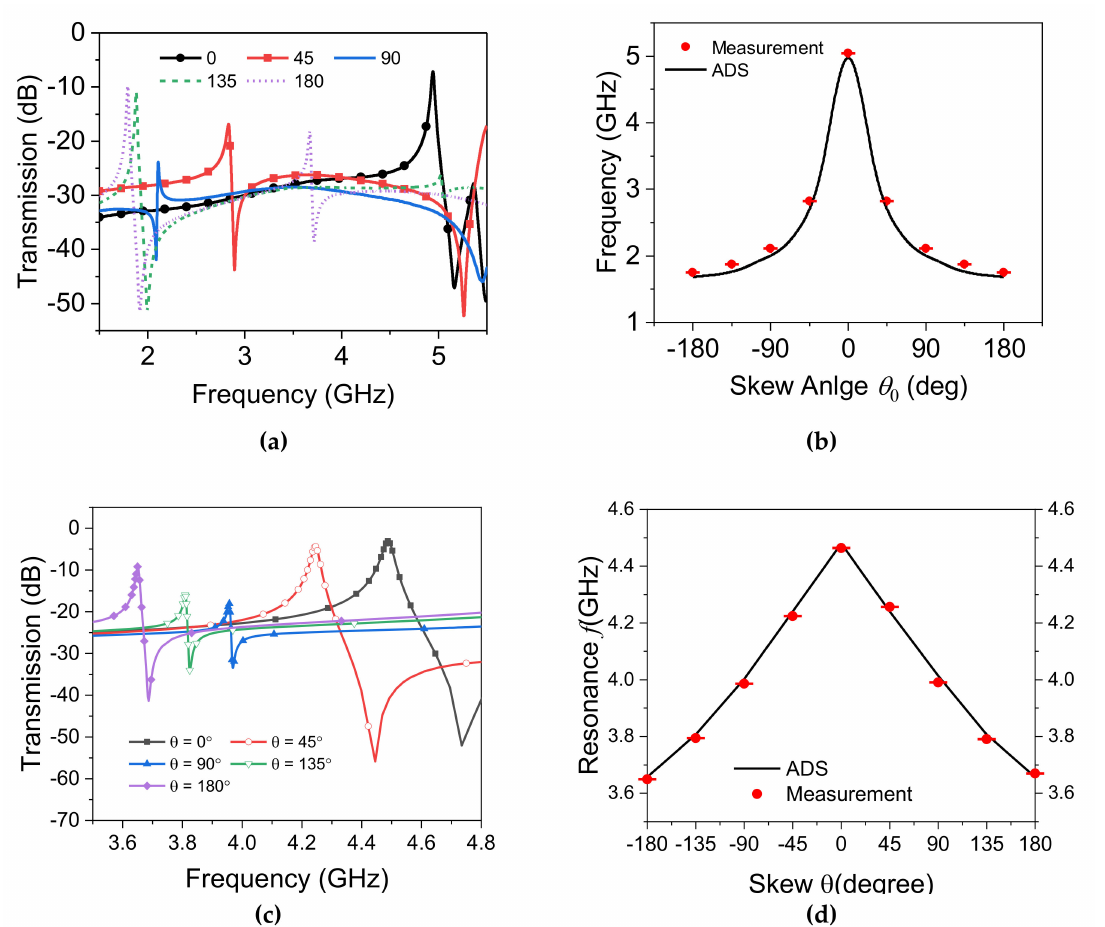
Figure 11. ( a ) Measured transmission profile variation due to rotation with the skew angles of 45, 90, 135, and 180 degrees, ( b ) comparison between simulation and measurement data for skew angle analysis, ( c ) measured transmission profile for thicker rotary DSRR on 0.8 mm substrate, ( d ) comparison between simulation and measurement for the modified sensor on thicker rotary